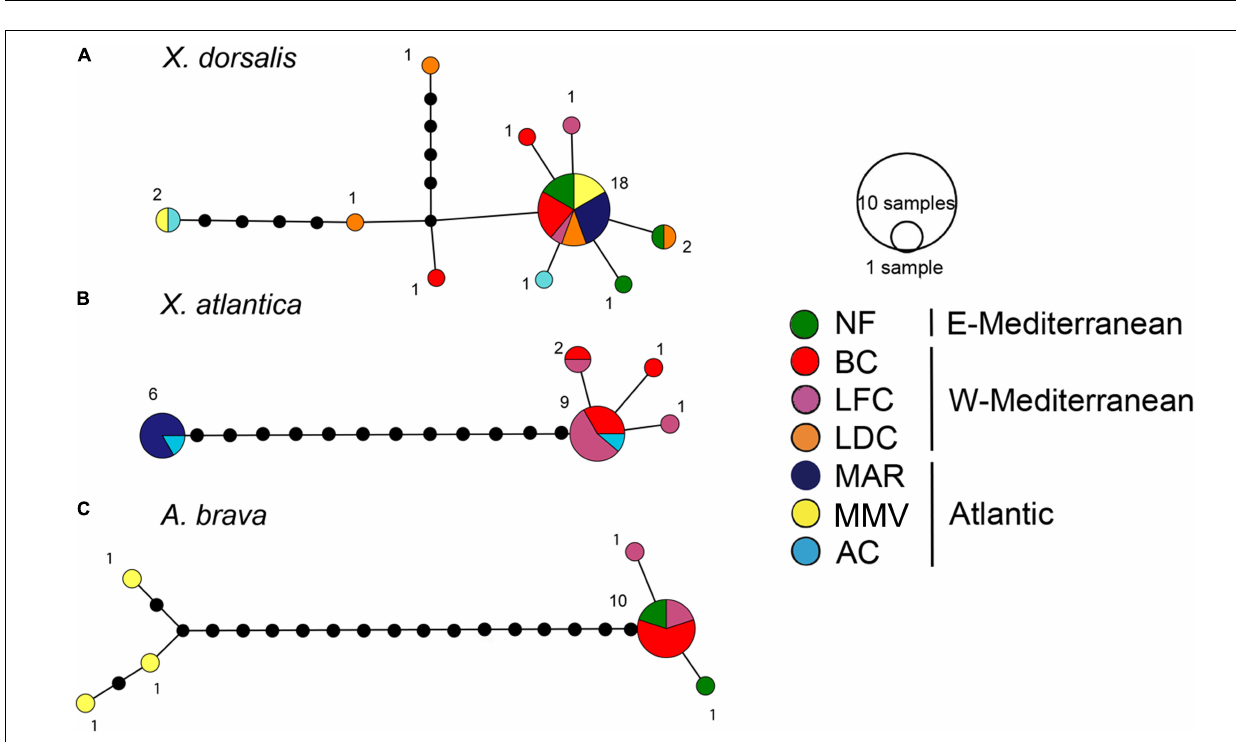
FIGURE 5 | Lateral views of shell with soft parts and inner shells: (A,B) Abditoconus cf. anselli ; (C,D) Abditoconus brava ; (E,F) Xylonora atlantica new comb.; (G,H) Xylophaga dorsalis. PAS = posterior adductor scar; PR = pedal retractor scar; SR = siphonal retractor scar. Redrawn from Romano et al. (2014).